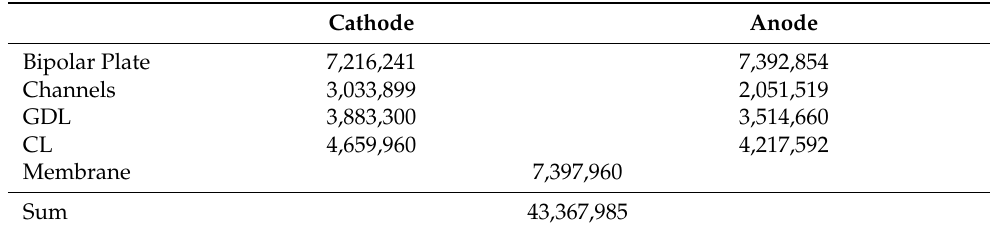
Table 2. Number of generated polyhedral